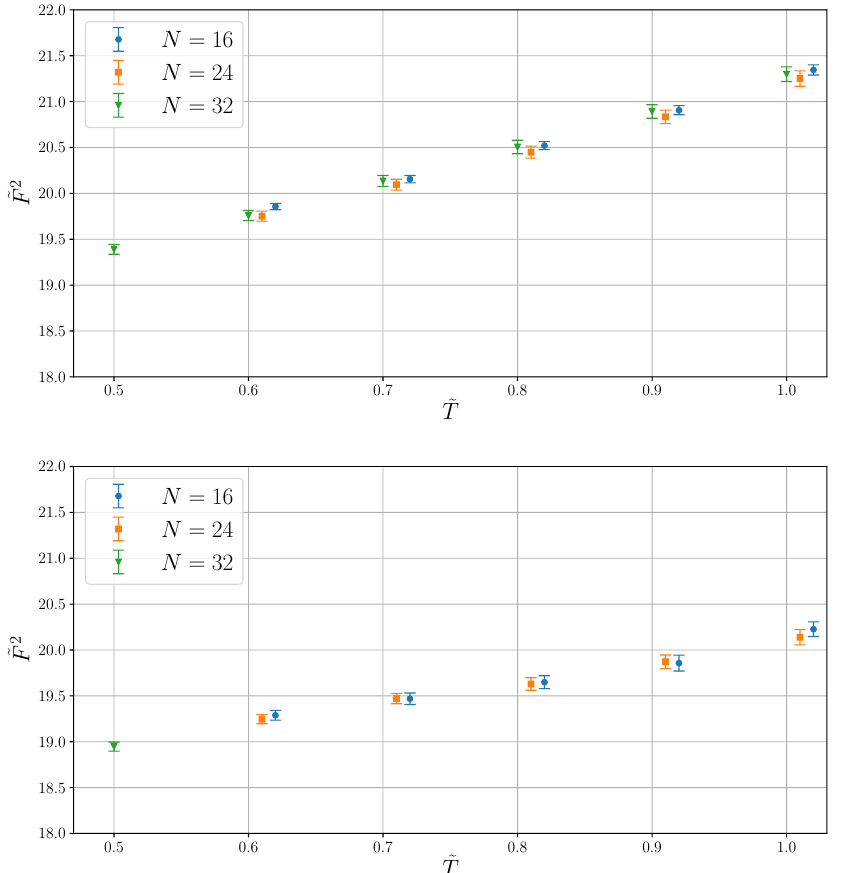
Figure 16. [Upper] The values of ~ F 2 in the continuum ungauged theory as a function of the temperature at three di(cid:11)erent values of N (including all lattice spacings in the continuum (cid:12)t). The error bars of the individual points at (cid:12)xed N , L and ~ T used in the continuum extrapolations have been increased by a factor of four. [Lower] Same as above, but for the gauged theory. The error bars of the individual points at (cid:12)xed N , L and ~ T used in the continuum extrapolations have been increased by a factor of